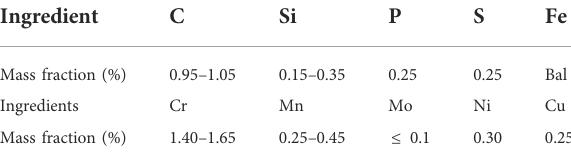
TABLE 1 Chemical composition of GCr15